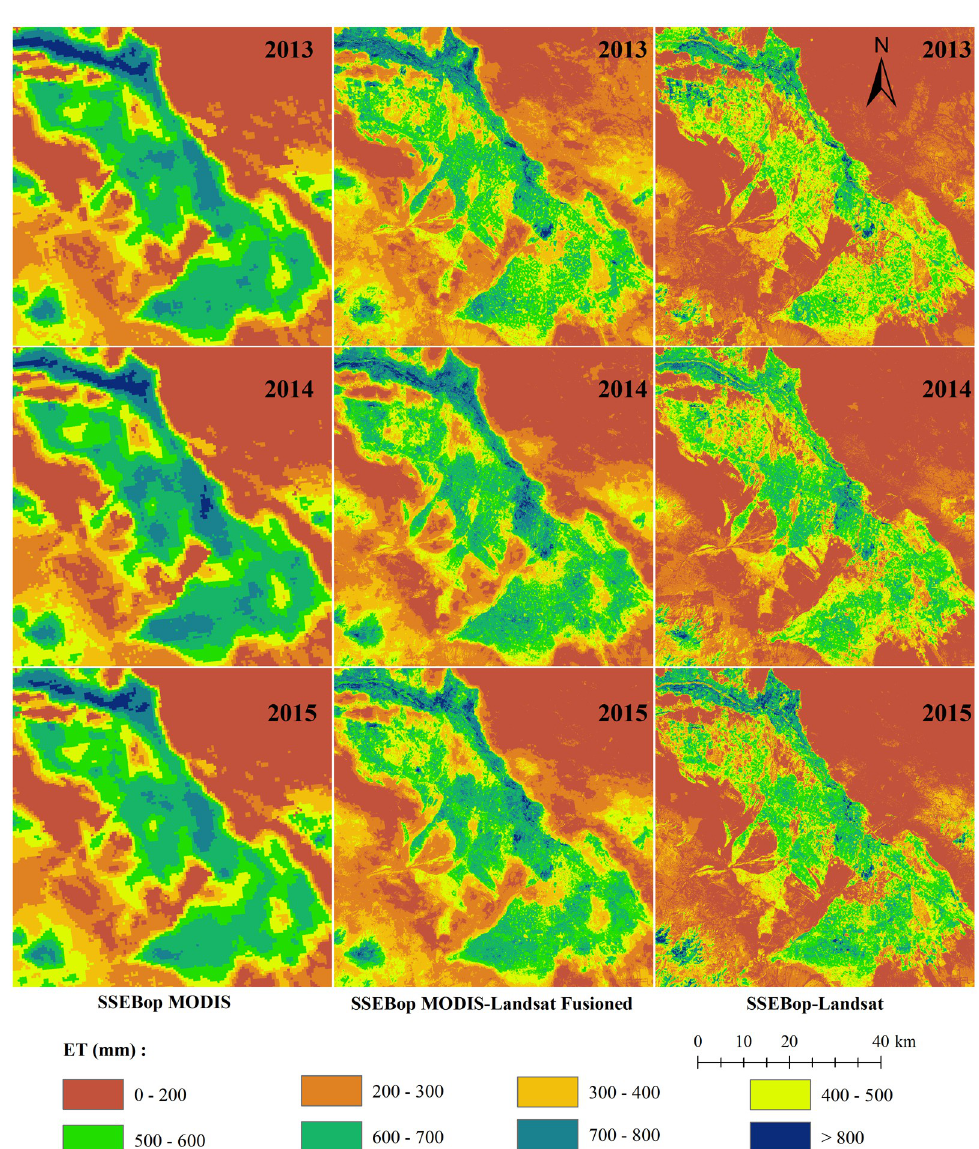
Fig 7. Yearly ET maps generated by the SSEBop MODIS, SSEBop MODIS-Landsat Fusioned, and SSEBop Landsat.